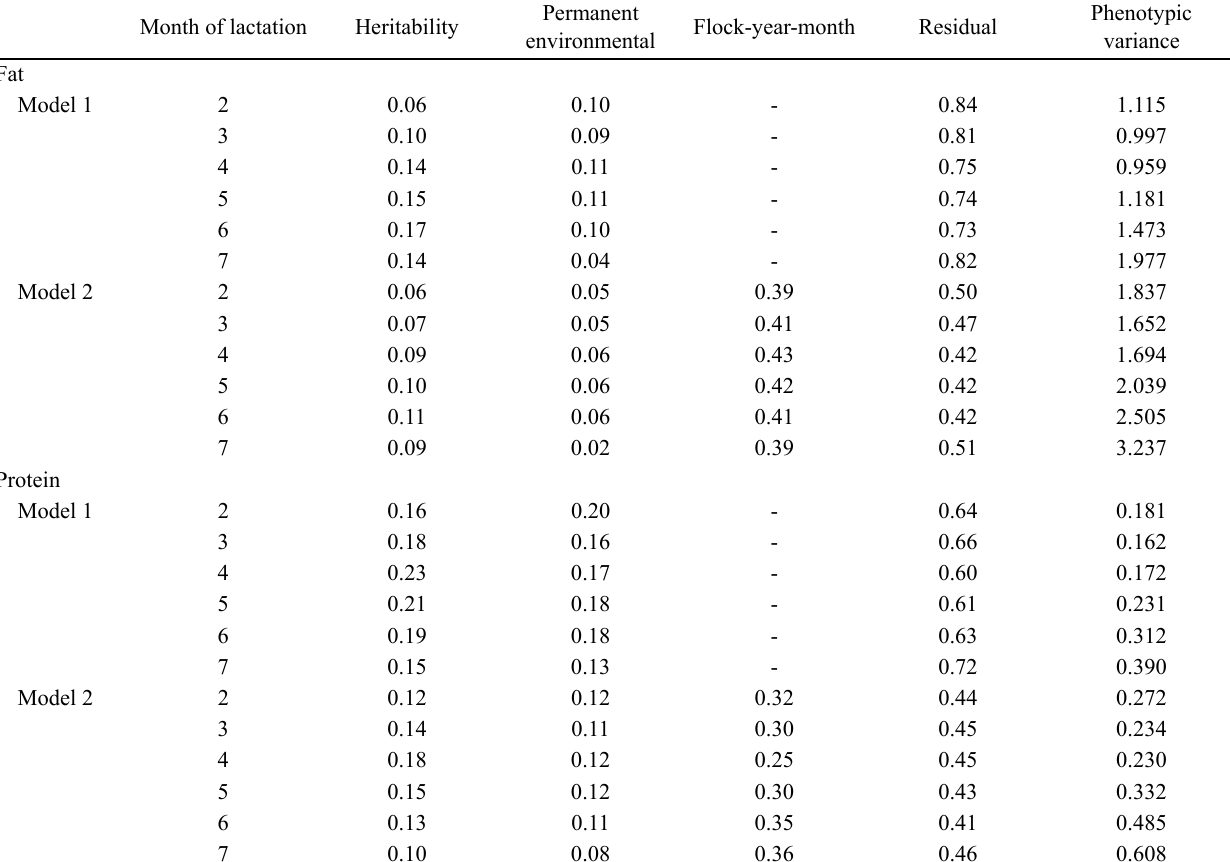
Permanent Flock-year-month Residual environmental